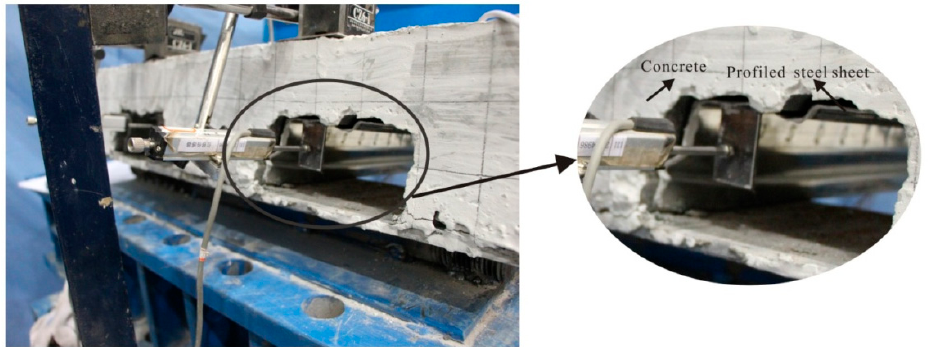
Figure 14. Load–slip behavior of different composites slabs. ( a ) SCLC-B-1, ( b ) SCRLC30-B-1, ( c ) SCLC- B-2, ( d ) SCRLC30-B-2.